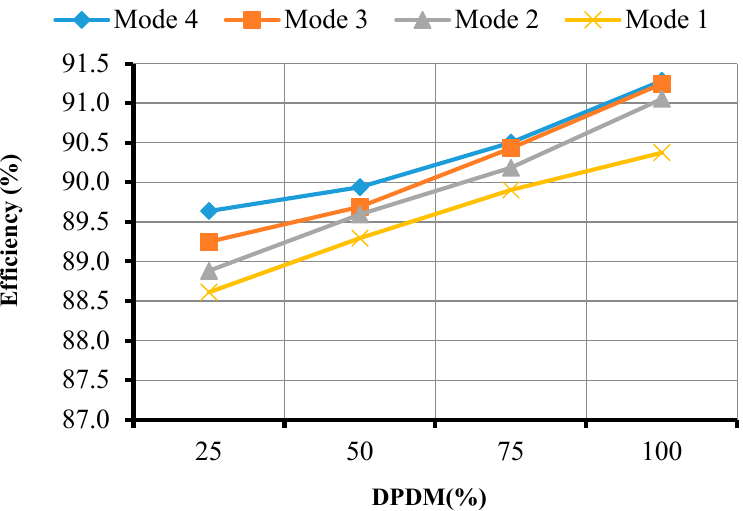
Figure 18. Efficiency of the proposed system for different modes at varying DPDM.